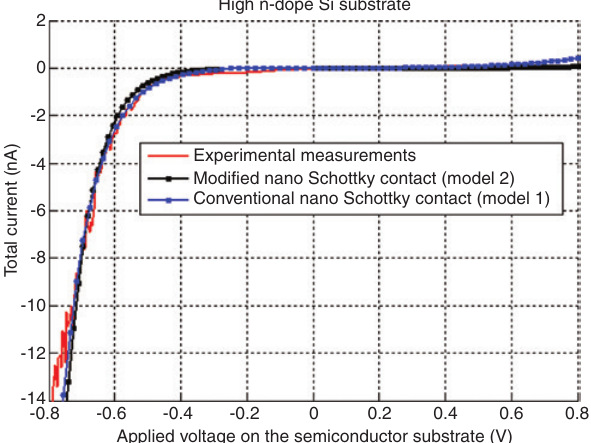
Figure 12: I-V data of the nano-Schottky junction between a nanotip and a low n-doped semiconductor substrate. The data show high contact